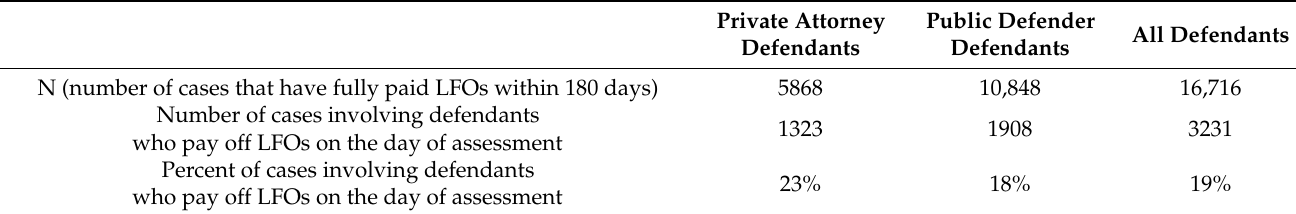
Table 5. Numbers and percentages of cases involving defendants who fully satisfy LFO payment on the day of